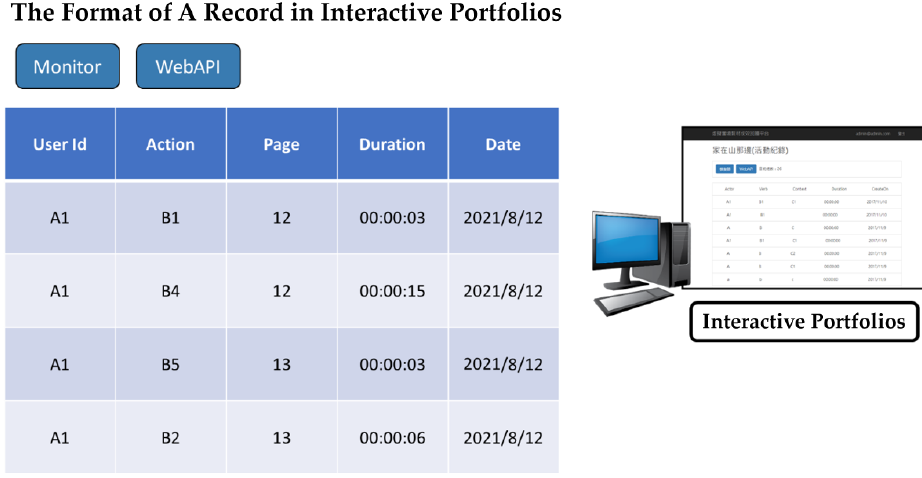
Figure 5. Each record in the interactive portfolio with five fields in xAPI